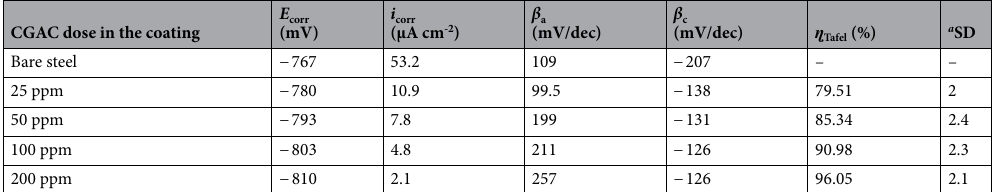
Table 2. Polarization corrosion parameters and the protection efficiencies for the bare and different coated mild steel samples in 3.5 wt.% NaCl solution at 25 °C. a SD, represents the standard deviation of three